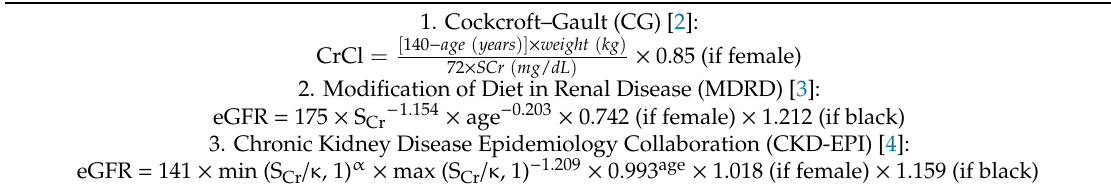
Table 1. Equations used to estimate renal function a